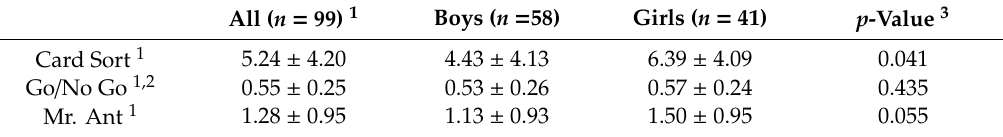
Table 3. Scores on the executive function tasks (mean ± standard deviation).